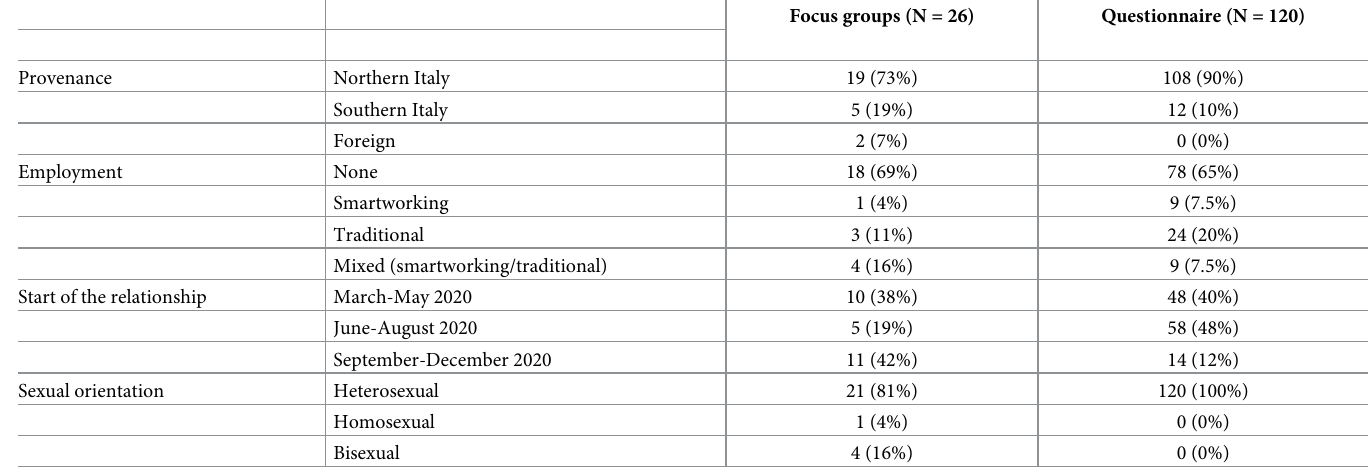
Table 2. Socio-demographic data of the